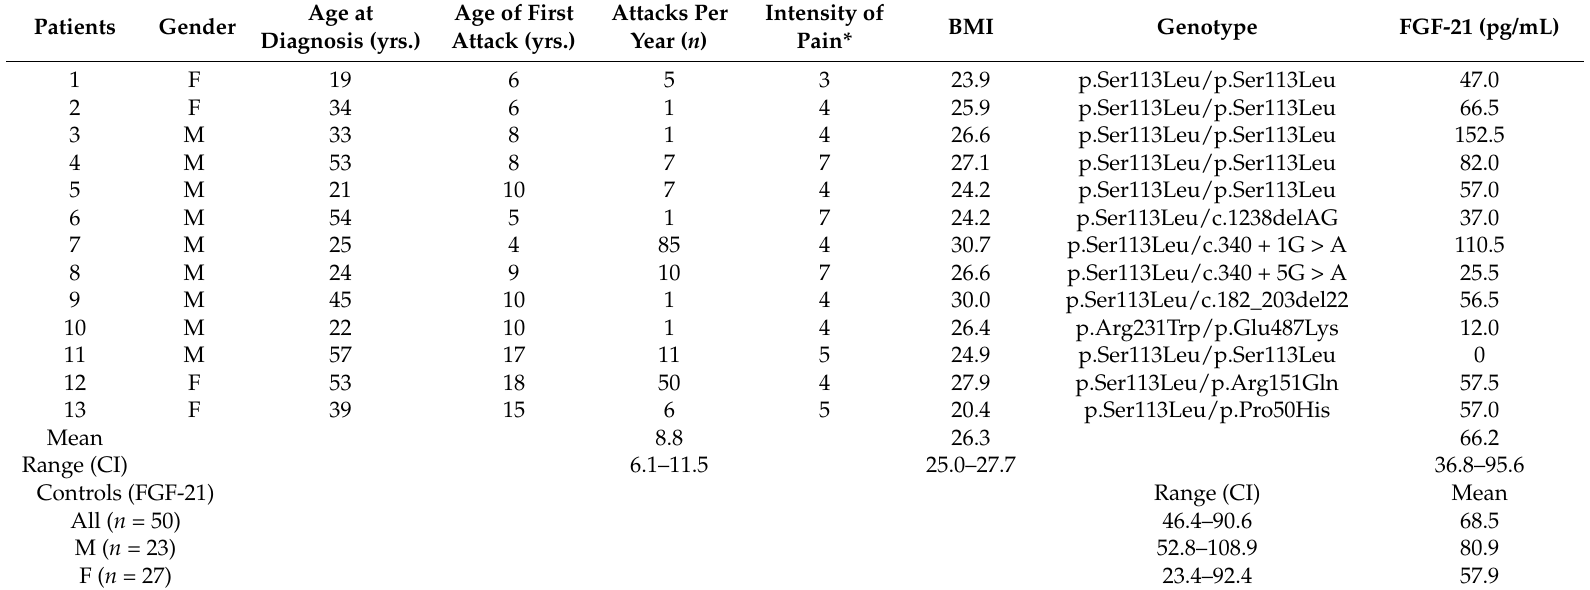
Table 1. Epidemiological data of